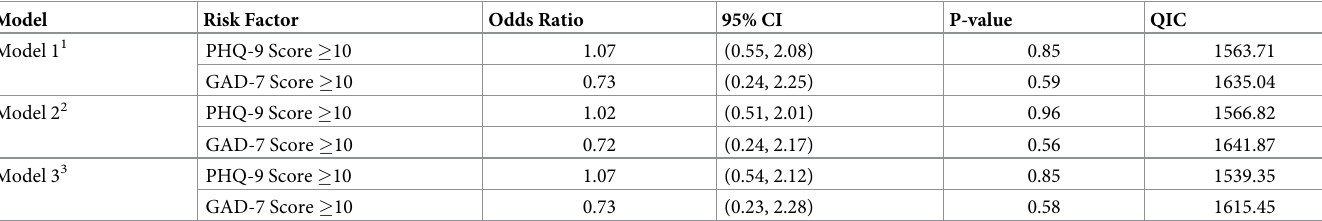
imputations MI analyses (see S1 Table for results of the multivariable analysis on MI datasets). Participants lost to follow-up were more likely to be men, have hypertension and central obe- sity, and reported more alcohol and tobacco use, less leisure time physical activity than partici- pants who were not lost to follow-up (see S2 Table). Table 2. Association of depression and anxiety with incident diabetes in multivariable